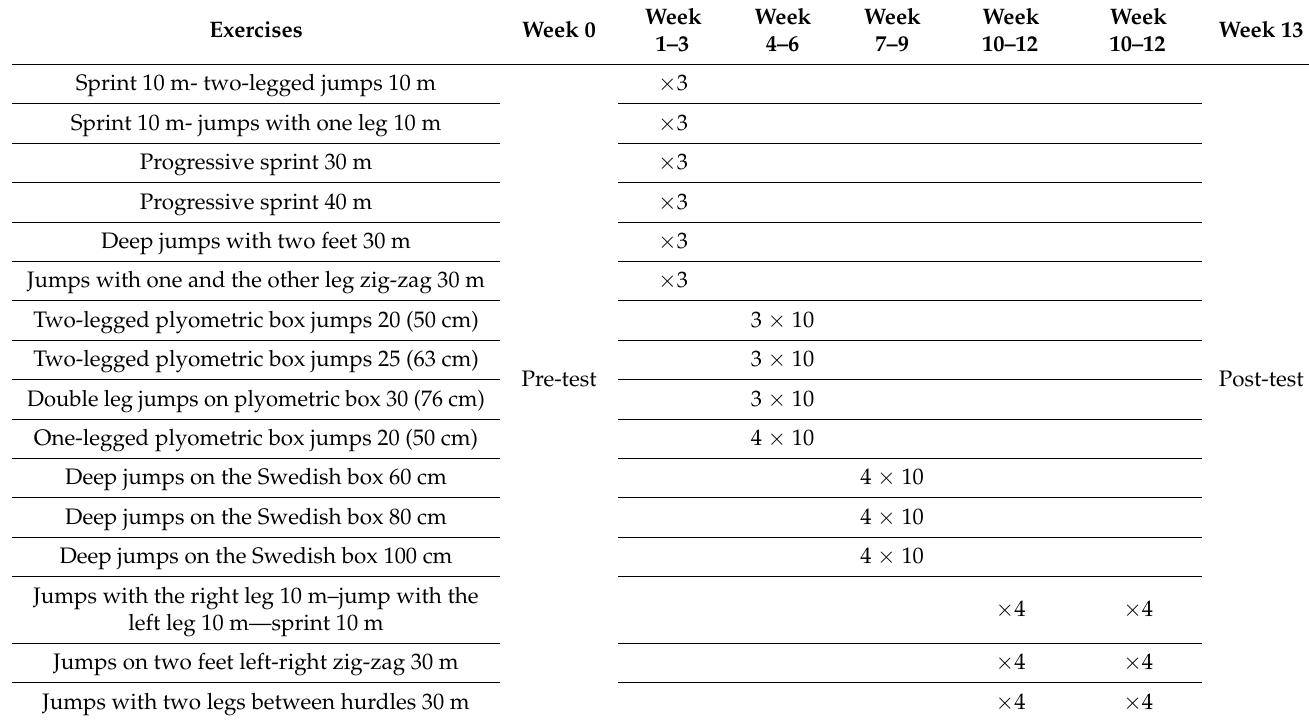
Table 2. Design of the plyometric training program